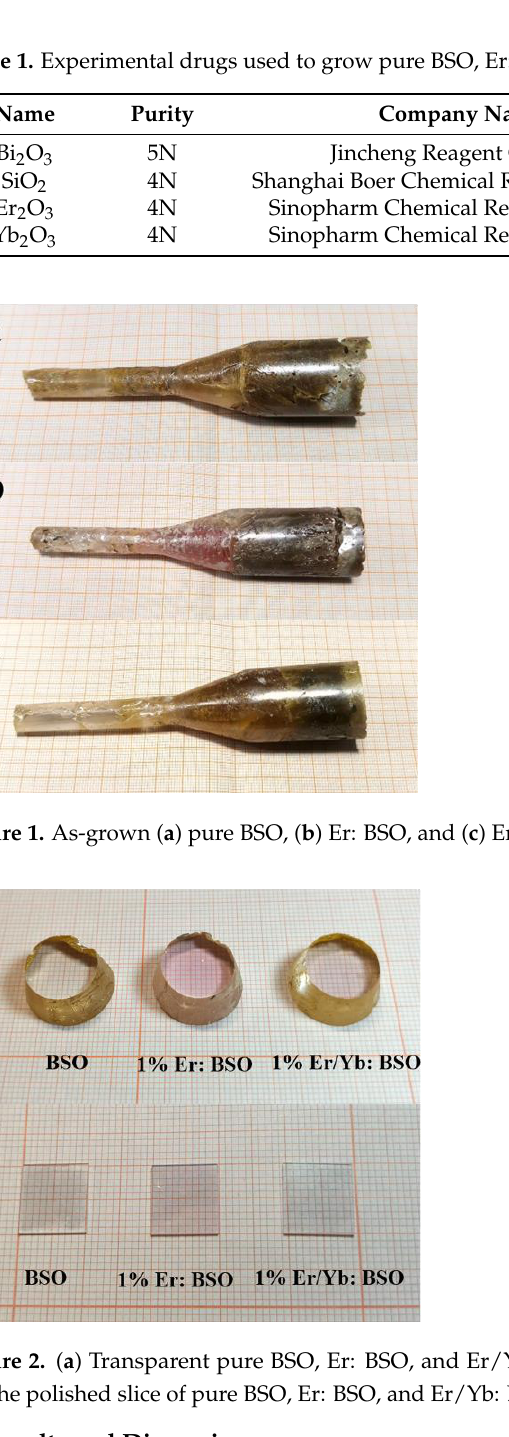
Figure 2. ( a ) Transparent pure BSO, Er: BSO, and Er/Yb: BSO crystals (10 mm in thickness) and ( b ) the polished slice of pure BSO, Er: BSO, and Er/Yb: BSO crystals (10 mm × 10 mm × 1 mm). 3. Results and Discussion 3.1. Crystal Growth The preparation of pure-phase polycrystalline is the key to ensure the successful growth of the BSO crystal because of the great difference between SiO 2 (the melting point of 1750 °C) and the Bi 2 O 3 melting point (850 °C) [24]. The segregation occurred easily dur- ing the growth, resulting in brown, circular Bi 2 O 3 -rich precipitates and white SiO 2 on the top [25]. The excess of Bi 2 O 3 or SiO 2 in polycrystalline raw materials may aggravate phase